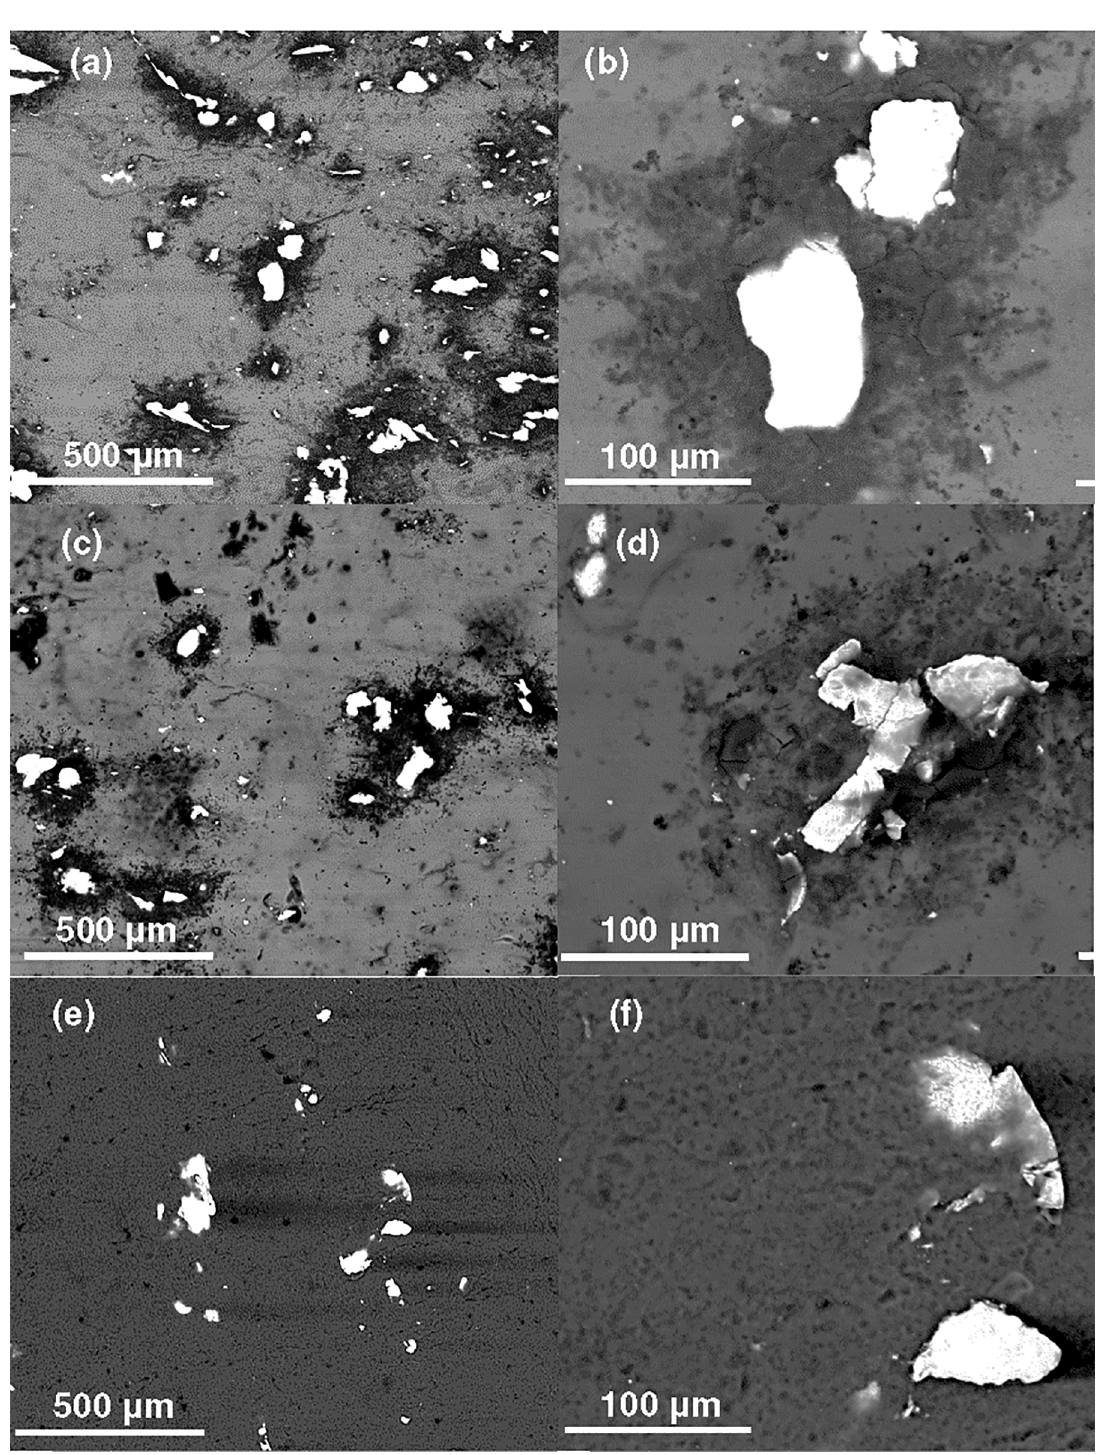
Figure 2. BSE-SEM micrographs (25 kV/9.8 mm - work distance/5.0 - spot) of Mg-8 mol% Fe samples after processing by ECR + ARB, with the folowing morphologies for Fe: (a, b,) LCNT, (c,d) LFRG and (e,f)